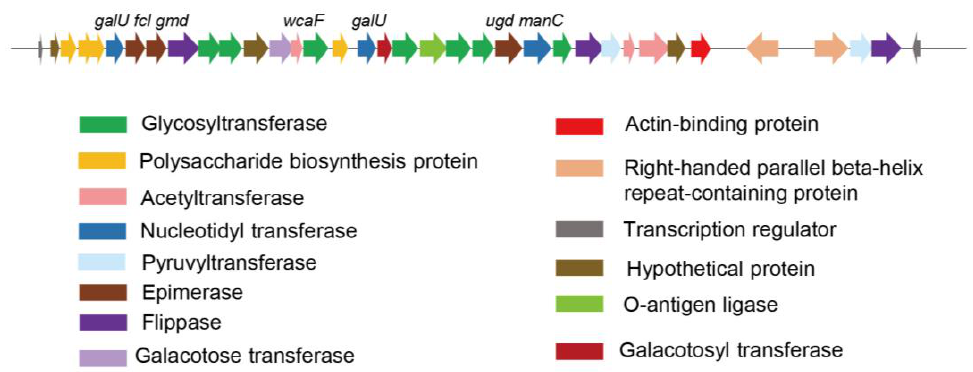
Figure 3. Predicted exopolysaccharide gene cluster for P. mucilaginosus G78. The predicted functions of each color-coded ORF are indicated at the lower bottom panel.